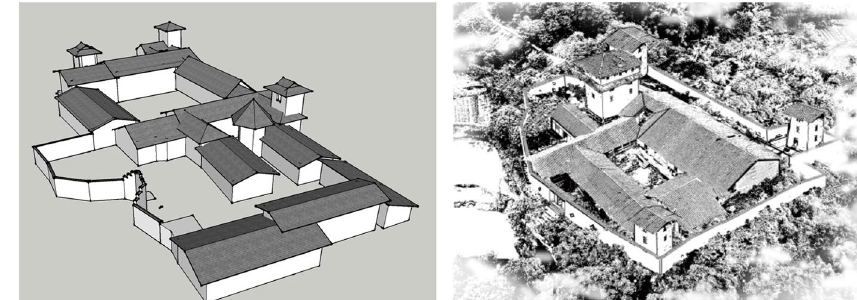
Fig. 7 Chongqing rammed earth manor watchtower with a flexible layout in Bishan and Jiangjing (Source: the